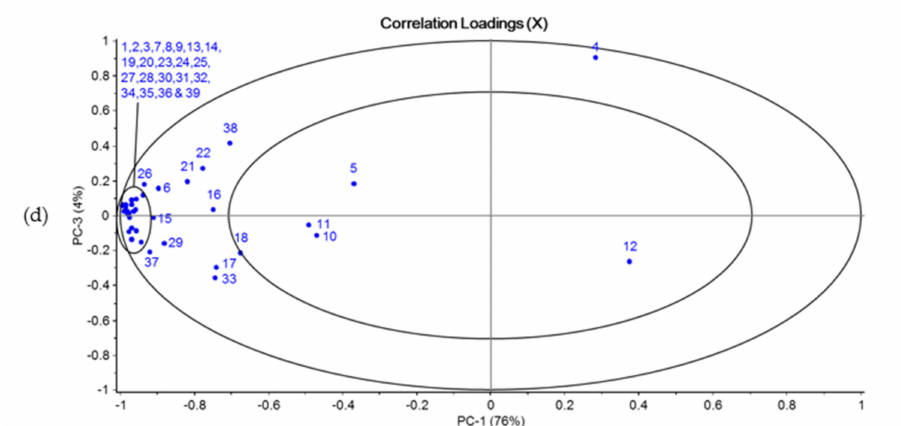
Figure A2. Principal component analysis (PCA) of volatile data from enzymatically extracted oils from by-products of Baltic herring. The samples are A: Alcalase (blue), N: Neutrase (red) and P: Protamex (green). The samples are also marked according to their extraction times 35 or 70 min. ( a ) Scores plot of Principal Components (PC) 1 and 2; ( b ) correlation loadings of PC1 and PC2; ( c ) scores plot of PC1 and PC3 and ( d ) correlation loadings of PC1 and PC3. The numbered volatiles are (1) acetaldehyde, (2) 2-propenal, (3) propanal, (4) butanal, (5) 2,3-butanedione, (6) unknown 1, (7) formic acid, (8) 1,3-butanediol, (9) acetic acid, (10) 3-methylbutanal, (11) heptane, (12) 2- methylbutanal, (13) ( Z )-2-butenal, (14) 2-ethylfuran, (15) 1-penten-3-one, (16) 1-penten-3-ol, (17) 2,3- pentanedione, (18) cyclopentanol, (19) propanoic acid, (20) ( E )-2-pentenal, (21) hexanal, (22) 2-methyl- 4-pentenal, (23) 3-hexanol, (24) 2,4-hexadien-1-ol, (25) ( E )-2-hexenal, (26) heptanal, (27) ( E , E )-2,4- hexadienal, (28) unknown 2, (29) 2-pentylfuran, (30) ( Z )-2-heptenal, (31) trans-2-(2-pentenyl)furan, (32) octanal, (33) hexanoic acid, (34) ( E , Z )-2,4-heptadienal, (35) ( E , E )-2,4-heptadienal, (36) ( E , E )-3,5- octadien-2-one, (37) 2-nonanone, (38) nonanal, (39) 5-ethyl-2(5H)-furanone, (40) ( E , E )-3,5-Octadien-2- one and (41) nonanoic acid.